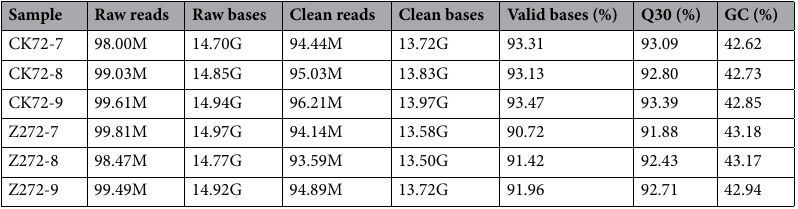
Table 1. Data statistics after transcriptome sequencing filtered for B. napus experimental